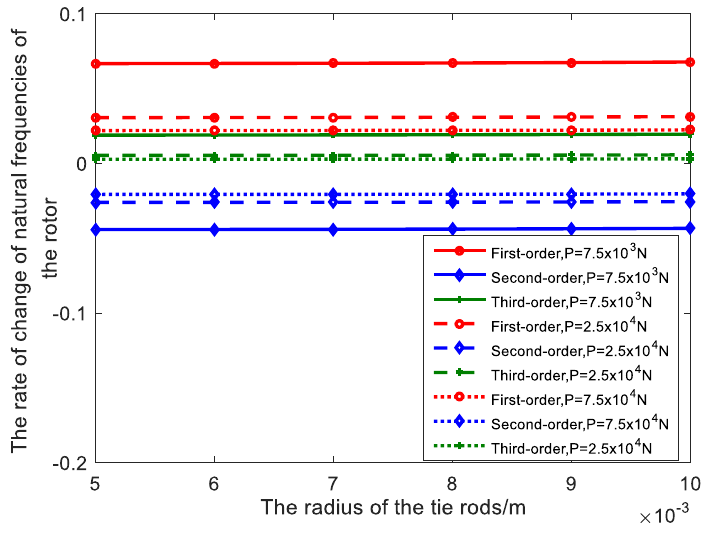
Figure 19. The rate of change of natural frequencies of the RFR with different radius of tie rods.